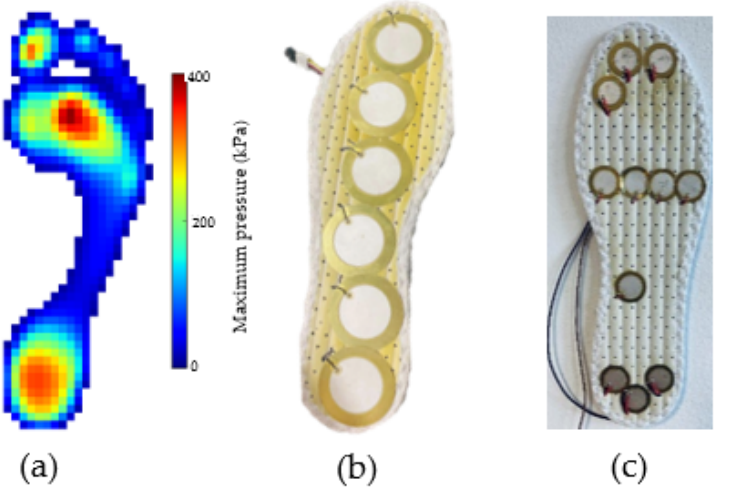
Figure 11. ( a ) Footsteps pressure distribution [47], ( b , c ) PEts distribution in the designed prototyping piezoelectric